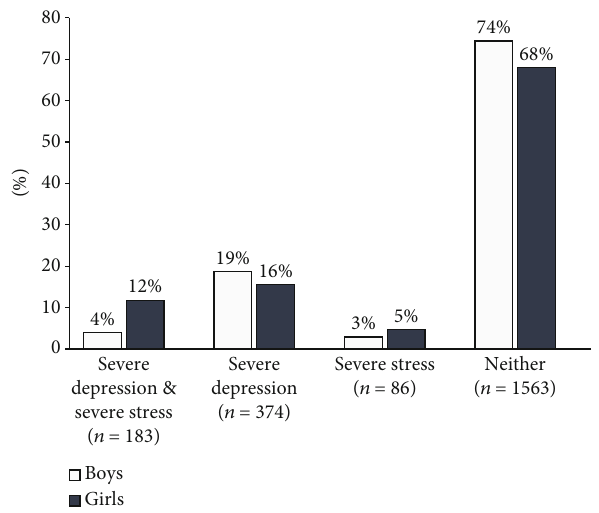
Figure 1: Mental health pro fi le of the students (severe depression and stress, severe depression only, severe stress only, and no severe depression or stress) strati fi ed by